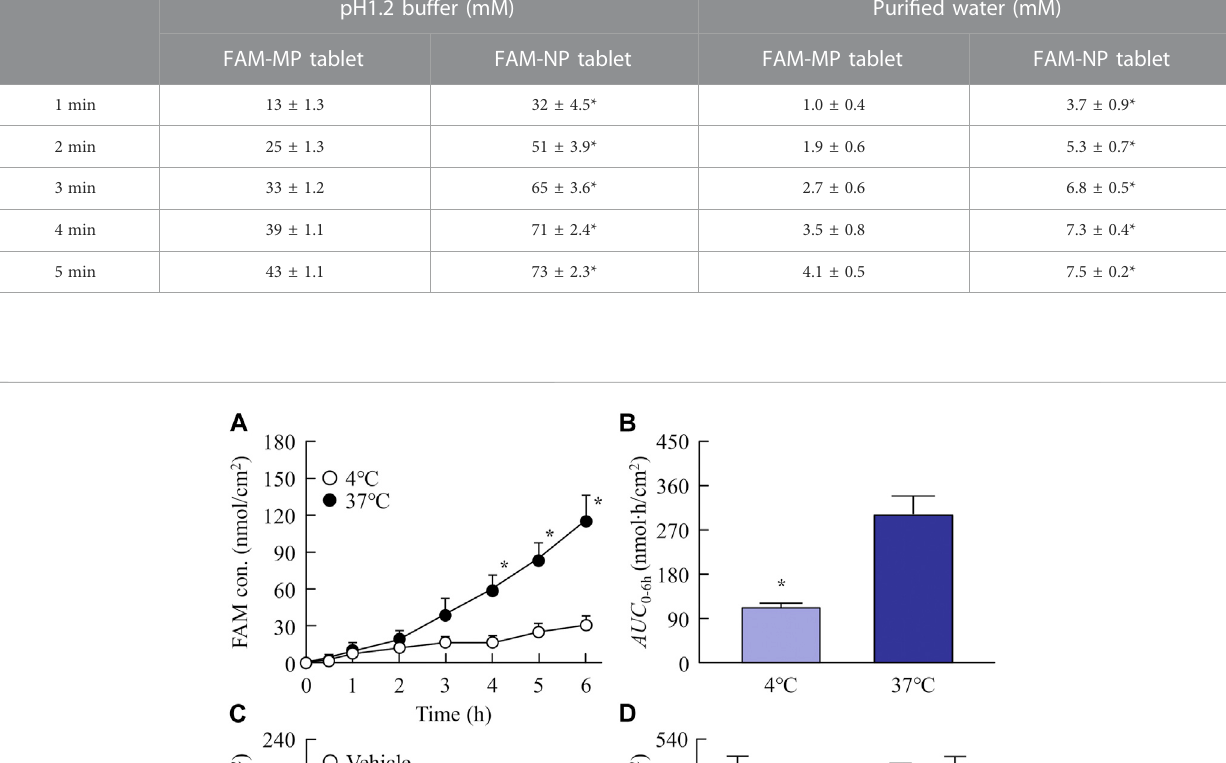
tablet (Supplementary Figure S1), and the amorphous phase